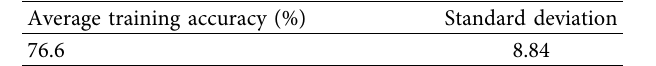
Table 7: Average training accuracy and standard deviation of the achieved training accuracies.